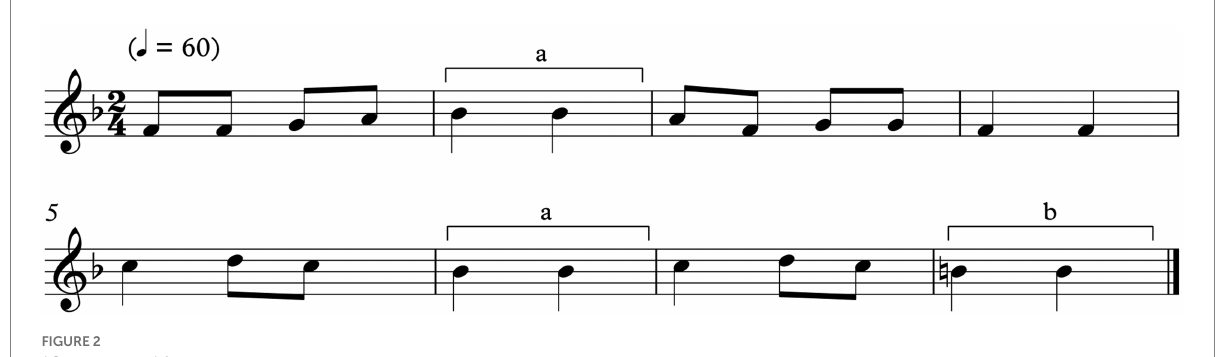
FIGURE 2 16-s tune used for